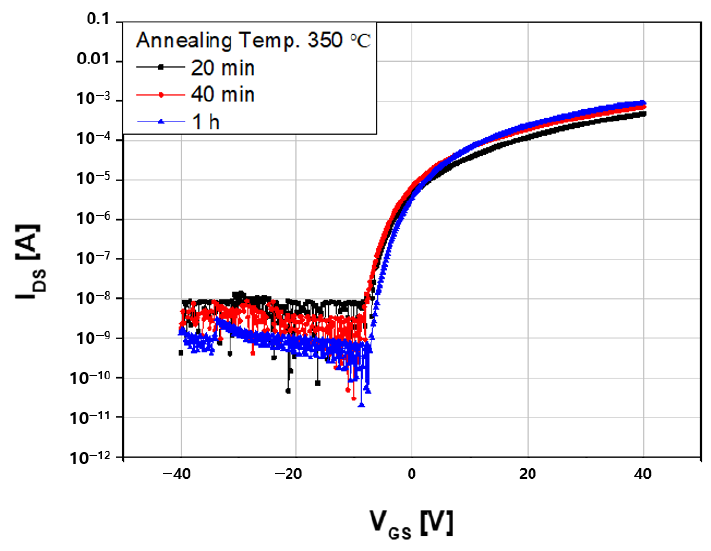
Figure 4. Transfer characteristic curves of self-ZTO DAL TFT at various annealing times.